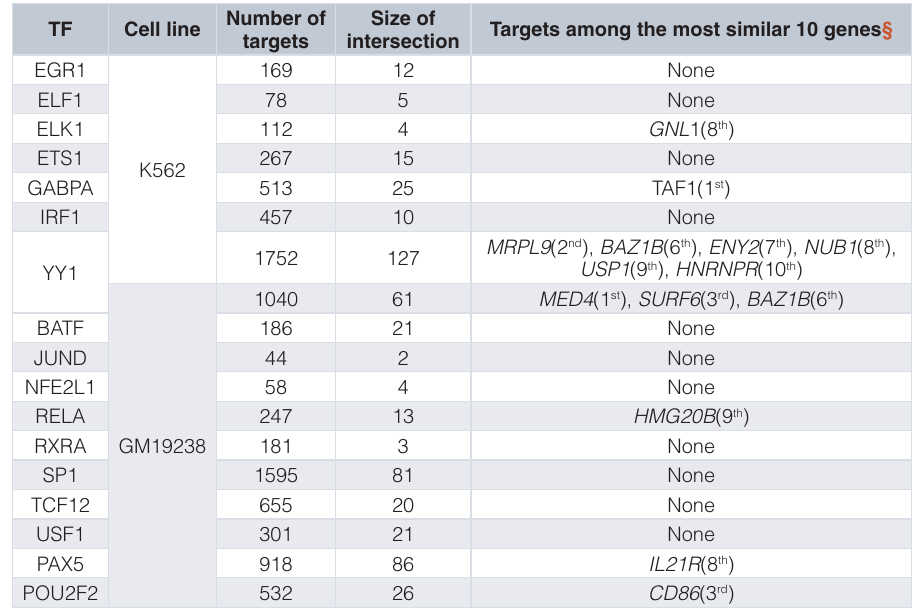
Table 4. Intersection of TF targets and 500 protein-coding genes with the most similar tissue- wide expression